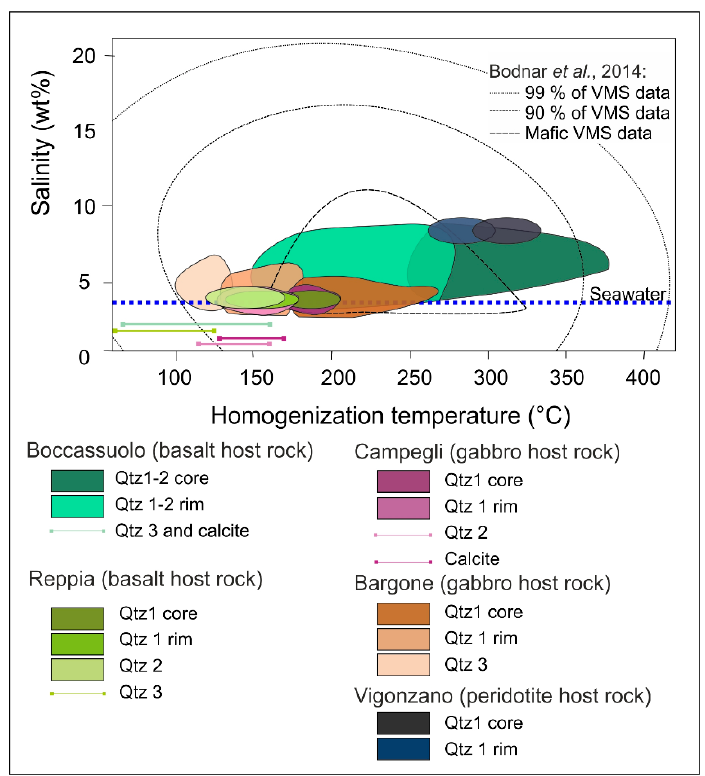
Figure 9. Homogenization temperature vs. salinity diagram of the fluid inclusions from the various Cyprus type VMS deposits in the Northern Apennines. A decreasing T h trend was observable among the different quartz generations as well as from the core to the rim of early Qtz 1. Where it was not possible to measure salinity, only the T h range of those inclusions is shown. Fields of the fluid inclusion homogenization temperature-salinity data for VMS deposits according to [12] are also shown.